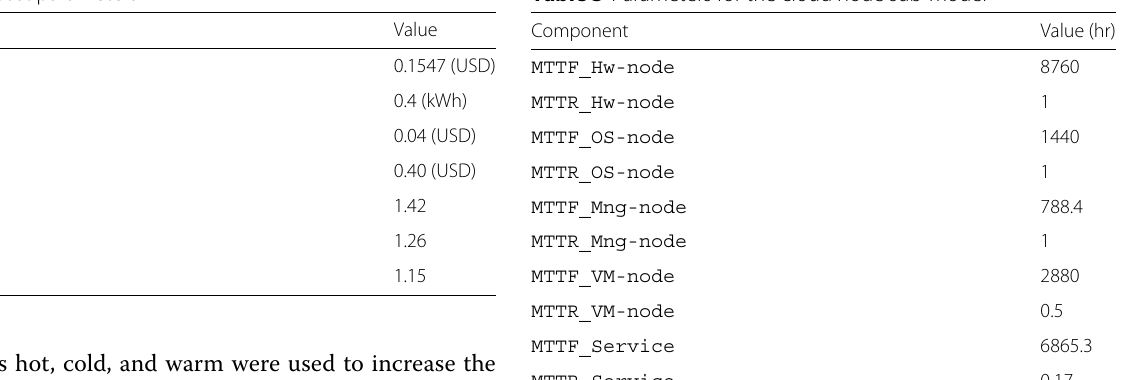
Table 3 Parameters for the cloud node sub-model